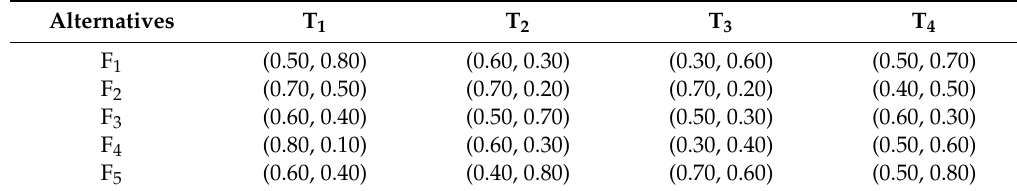
Table 2. Pythagorean fuzzy matrix by DM 2 .